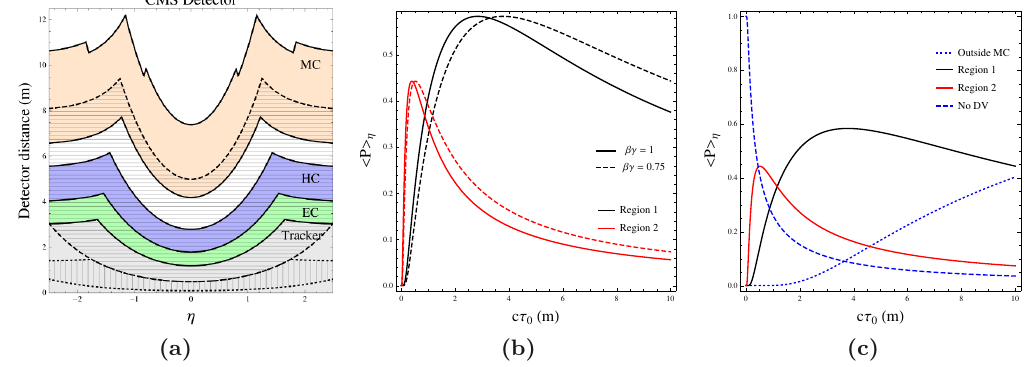
Figure 6. (a) Geometry of the CMS detector as a function of the pseudo-rapidity η . From bottom to top, one has the inner tracker (grey area), the EM calorimeter (green area), the hadronic calorimeter (blue area) and the muon chamber (orange area). The horizontal and vertical hatched areas correspond to Region 1 and 2, respectively (see text). (b) Averaged decay probability of the heavy neutrino as a function of its proper decay length cτ 0 for two values of the βγ relativistic factor and for Region 1 and 2 of the detector, as explained in the text. (c) Averaged decay probability of the heavy neutrino for βγ = 0 . 75 in four different regions of the